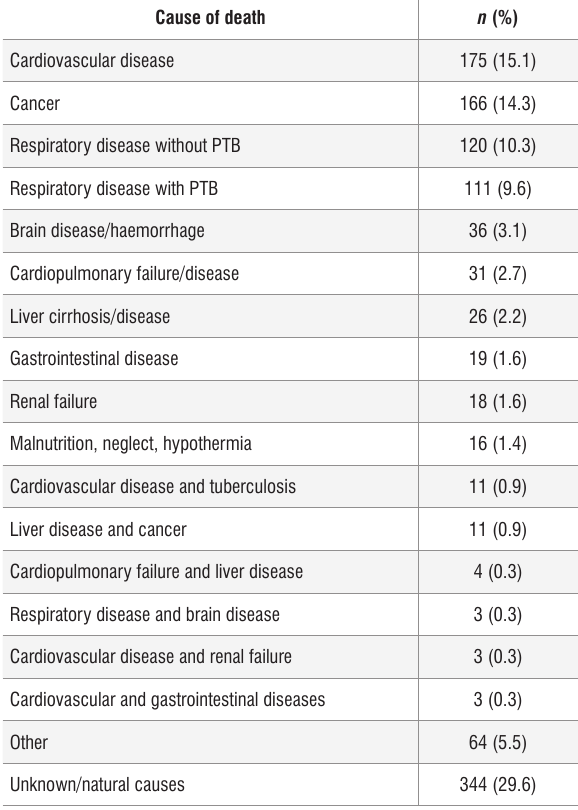
Cause of death as stated on the death